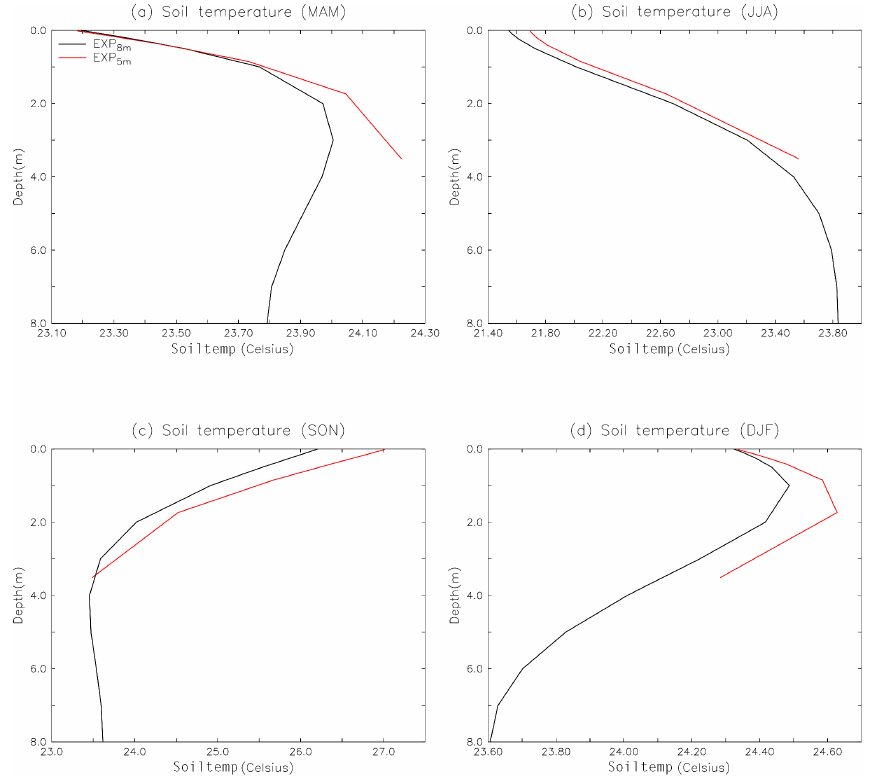
Figure 6. The vertical profiles of soil temperature in March-April-May (MAM) (a) , June-July-August (JJA) (b) , September-October- November (SON) (c) , and December-January-February (DJF) (d) over Brazil (50–70 ◦ W, 5–20 ◦ S) for 8M17L (EXP 8m , black line) and 5M7L (EXP 5m , red line) vertical